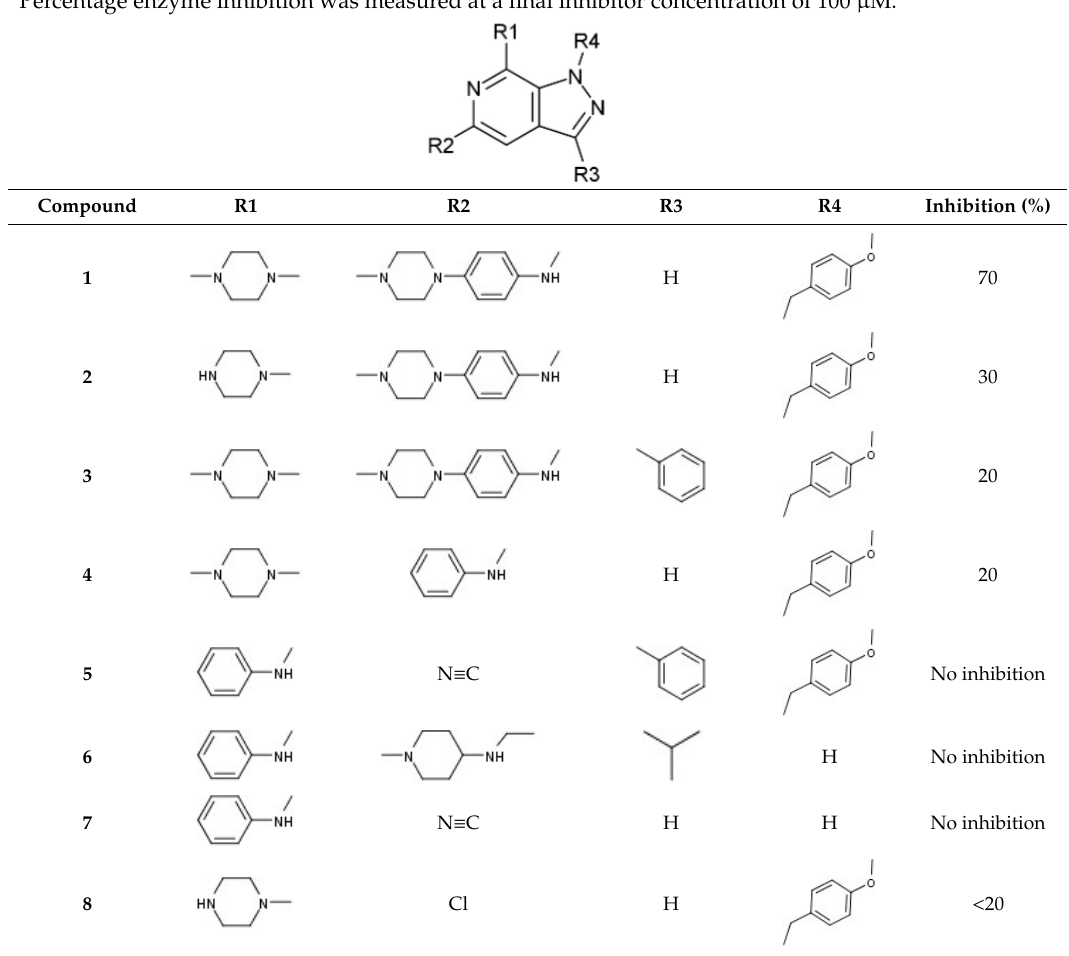
H Table 1. The inhibitory activity of the 8 pyrazolo[3-c], pyridine derivatives against full length CBS. Percentage enzyme inhibition was measured at a final inhibitor concentration of 100 μ